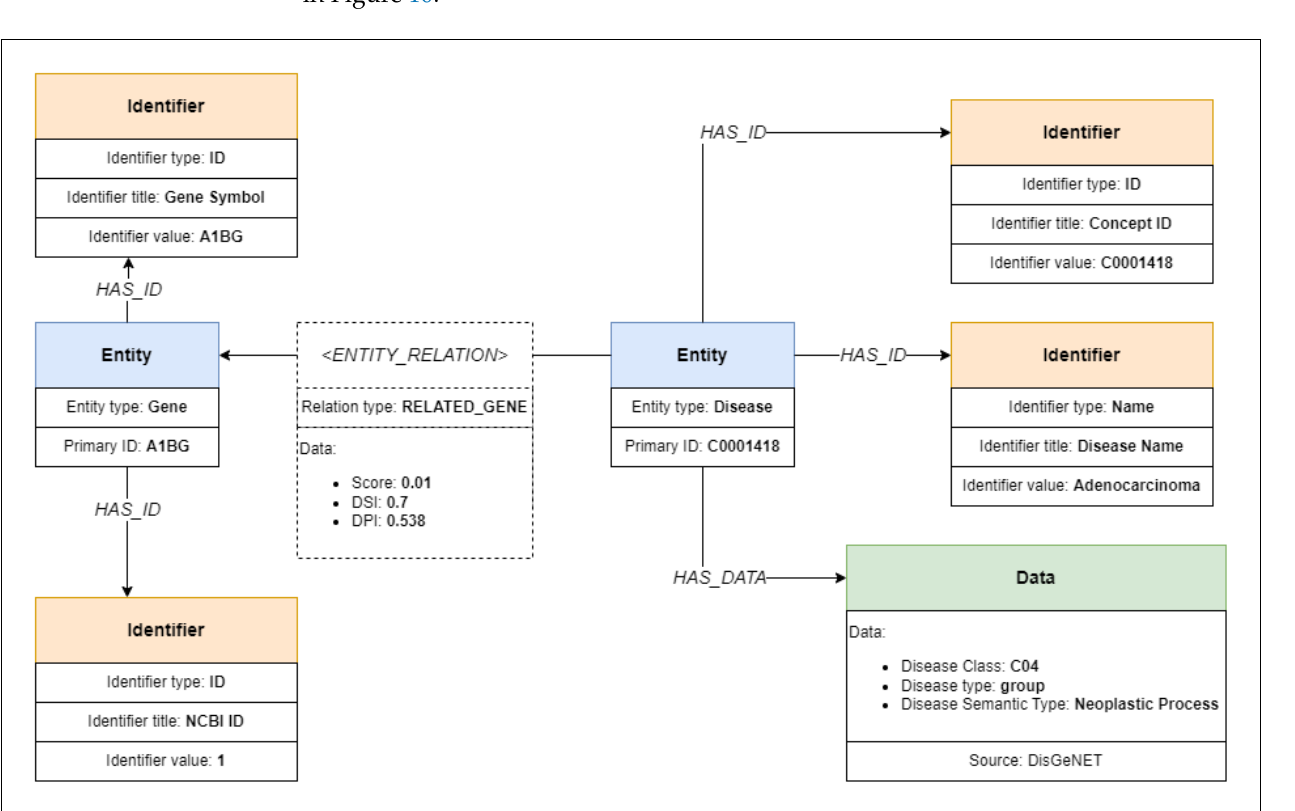
Figure 10. Diagram representing metadata from DisGeNET dataset record mapped to Bio- Graph